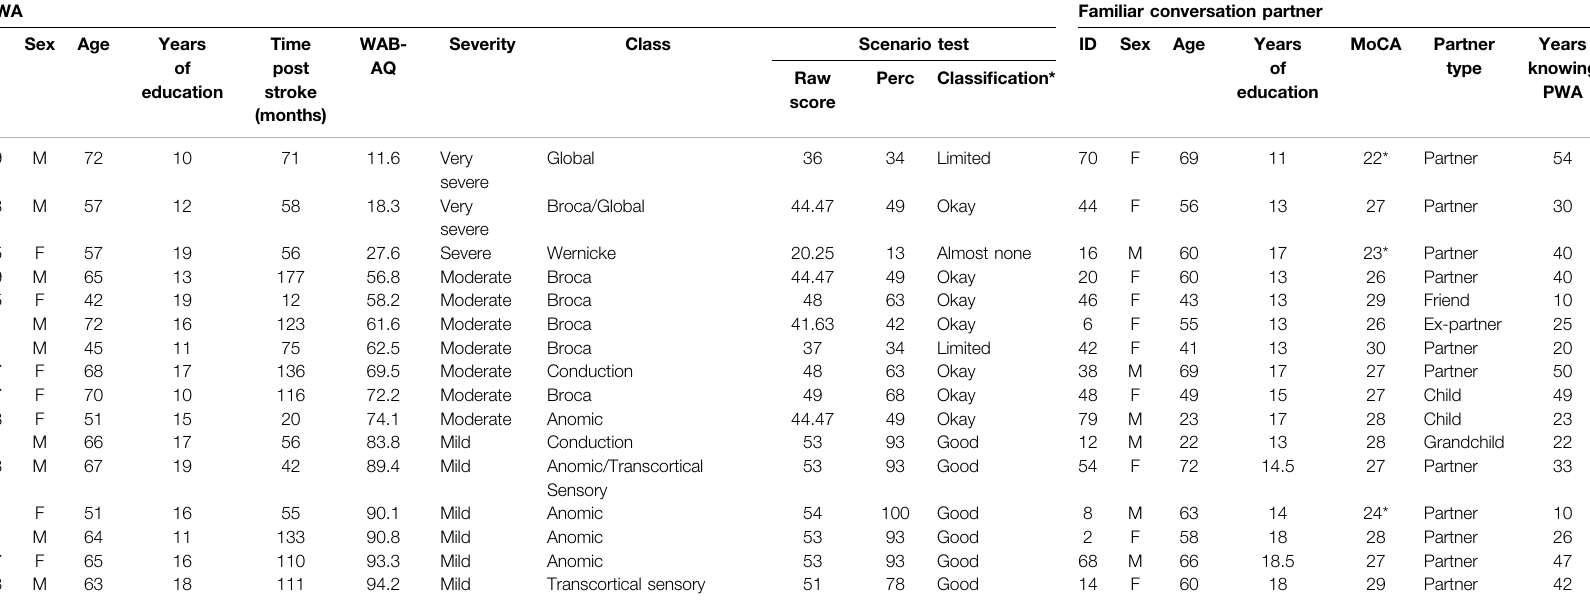
TABLE 3 | Descriptive for PWA and their familiar conversation partners, ordered by WAB-AQ score (lowest to highest). Scenario Test classi fi cation is based on the percentiles of the Dutch norm group, solely used here to provide a descriptive classi fi cation. PWA Familiar conversation